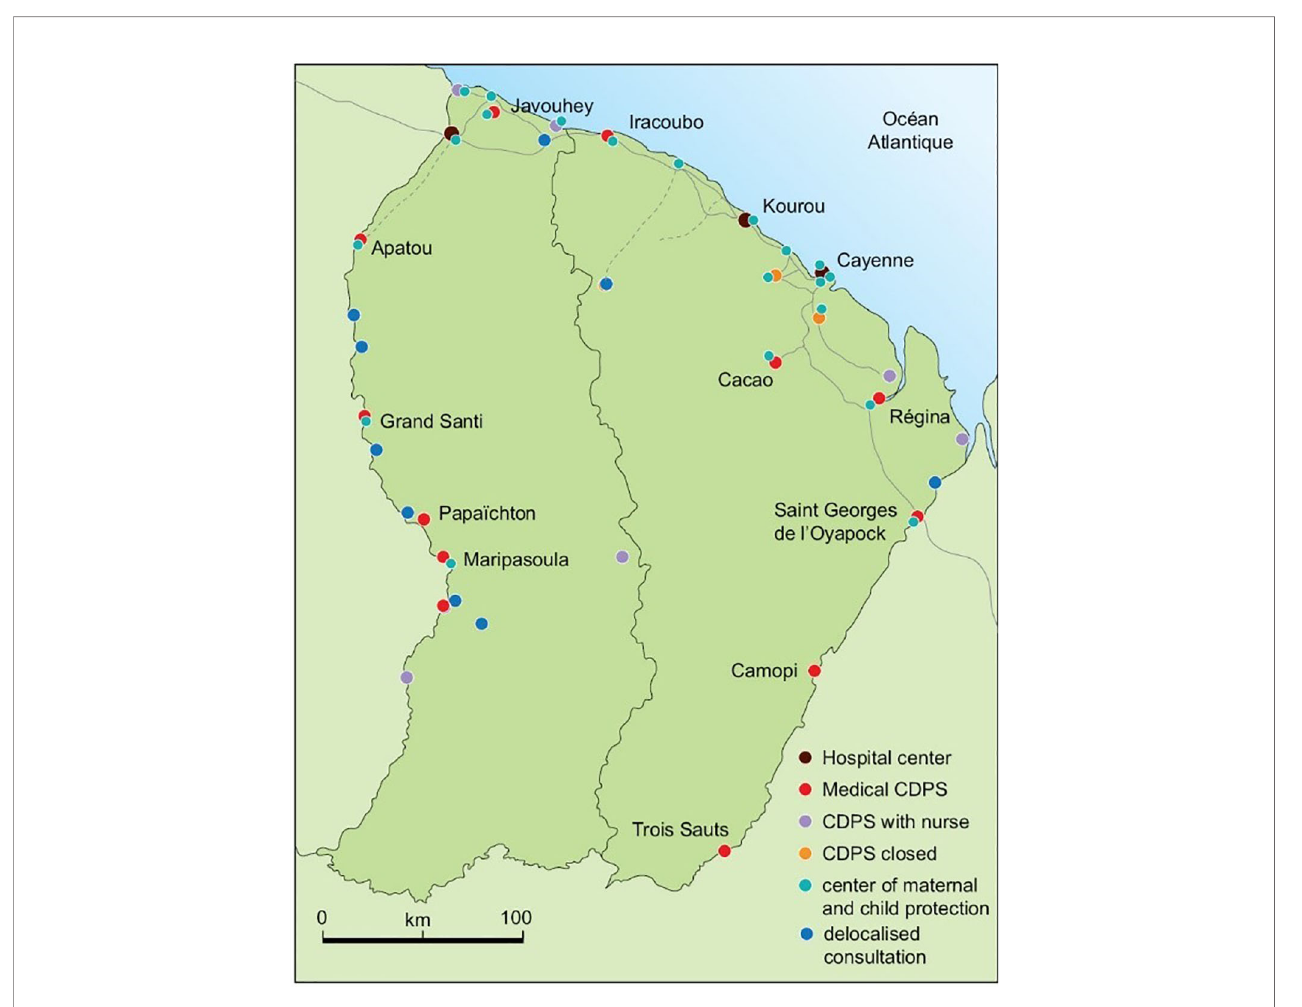
FIGURE 1 | Map of French Guiana and the main hospitals and delocalized health centers. CDPS, community health care